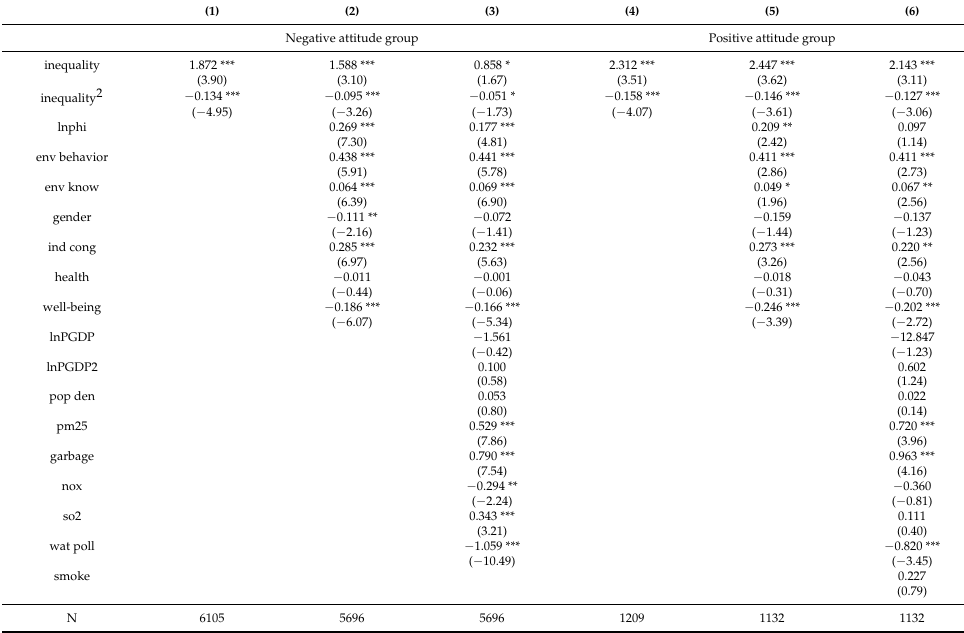
Table A12. The effect of individual-level income inequality on subjective environmental pollution: differences in environmental